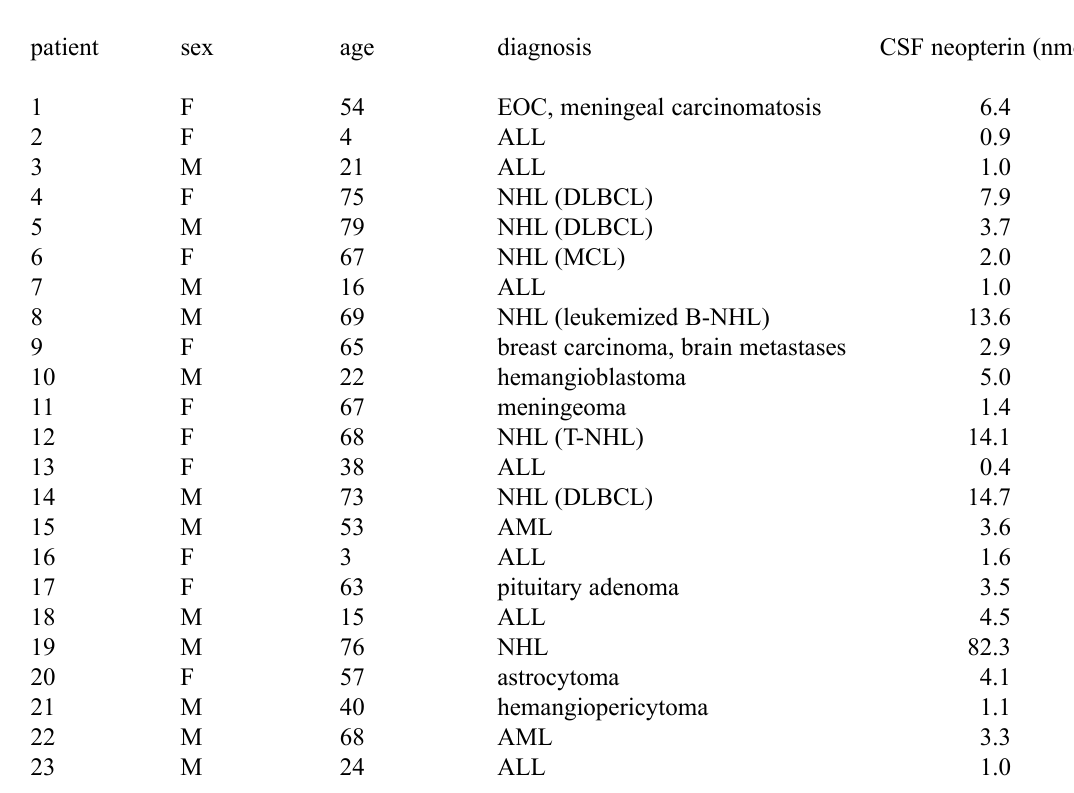
Table 1. CSF neopterin concentrations in patients with tumors. ALL acute lymphatic leukemia; AML acute myeloid leukemia; DLBCL diffuse large B-cell lymphoma; EOC epithelial ovarian carcinoma; F female; M male;